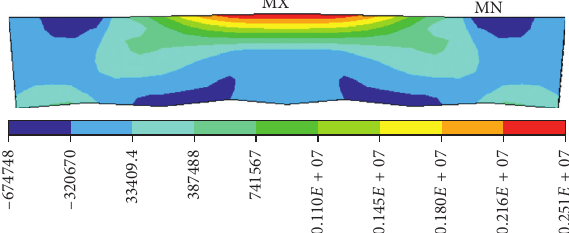
Figure 9: First principal stress of tunnel substructure